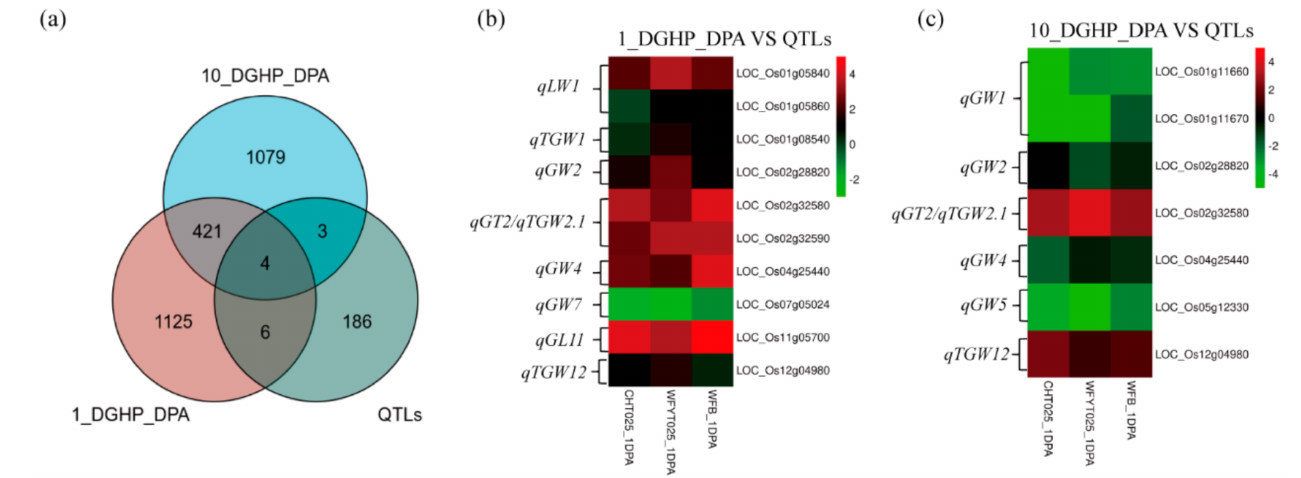
Figure 8. Candidate genes screened after QTL mapping combined with RNA sequencing. ( a ) Venn diagram of candidate genes between the DGHPs on 1 and10 DPA and QTL locus. ( b ) Heat map of FPKM expression in WFYT025 and parental grains of 10 candidate genes on 1 DPA. ( c ) Heat map of FPKM expression in WFYT025 and parental grains of seven candidate genes on the 10